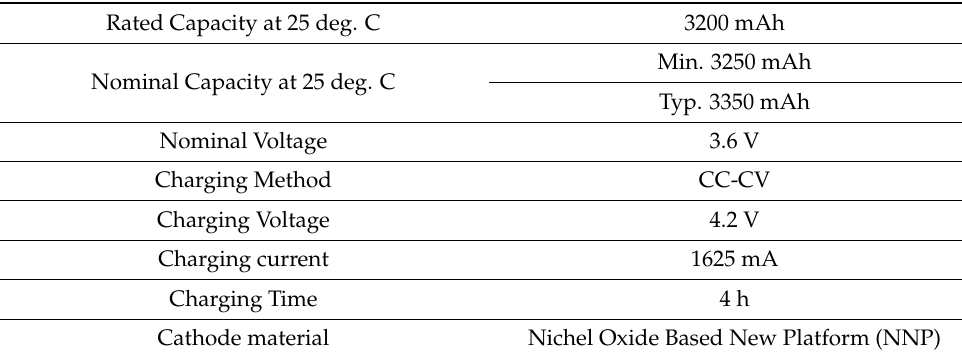
Table 1. Panasonic NCR18650B